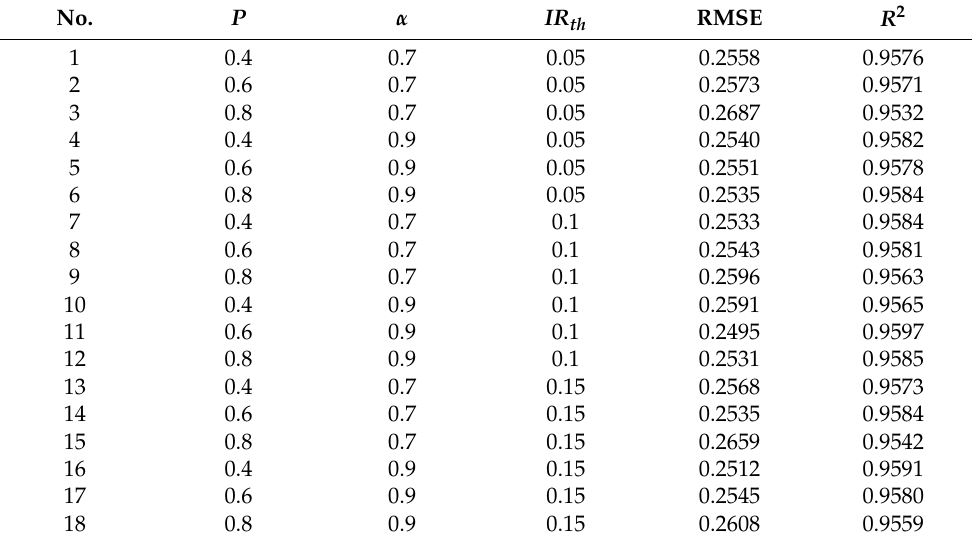
Table 8. Performance comparison of the proposed method under different parameters for substrate concentration prediction.